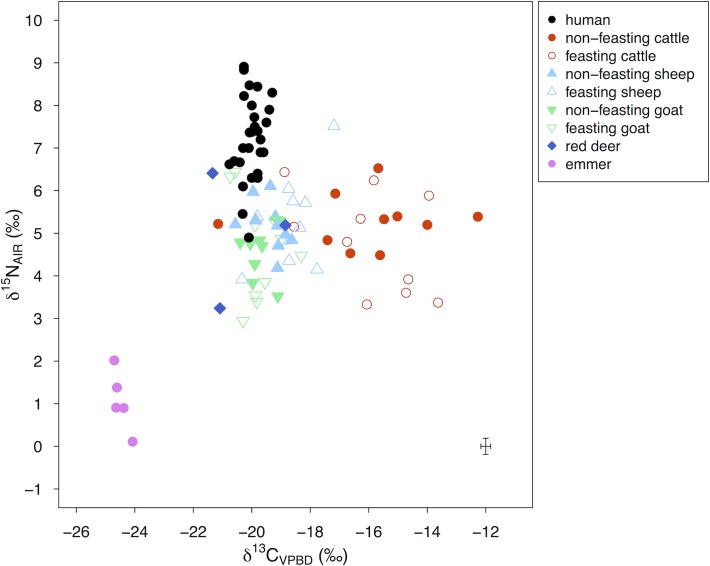
δ13C and δ15N values of bone collagen and charred emmer grain from Makriyalos I separated by context.Samples from feasting contexts (Pit 212 and Pit 214) are shown using open symbols. Samples from non-feasting contexts (habitation) are shown using filled symbols. Measurement error is shown in the bottom-right corner of the plot. Included are also previous measurements of contemporary human samples (n = 18) [12]. Summary statistics of three out of the five emmer grains presented in this table have previously been published in [84].